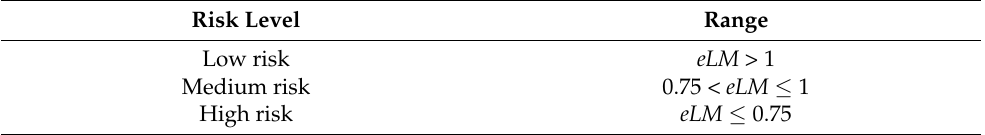
Table 1. Risk levels associated with eLM